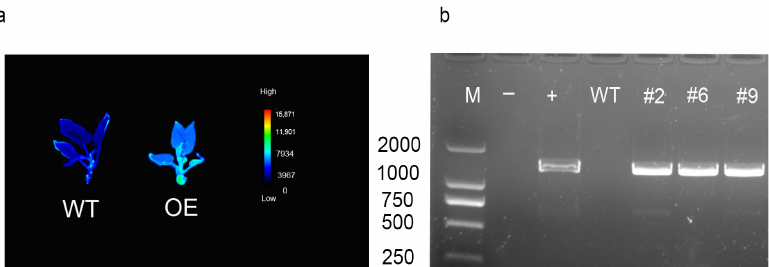
Figure 6. Identification of positive transgenic A. chinensis plants. ( a ) Based on the expression of GFP reporter genes in plants. ( b ) The PCR detection of T 1 A. chinensis transgenic lines. M, 2000 bp marker; − , ddH2O; +, the recombinant plasmid containing AvCIPK11 ; WT, wild type kiwifruit; and #2, #6, #9, positive transgenic lines. The forward primer was designed at 5 (cid:48) of 35S and the reverse primer was designed at 3 (cid:48) of AvCIPK11 . The pair of primers can be found in supplementary Table S4.